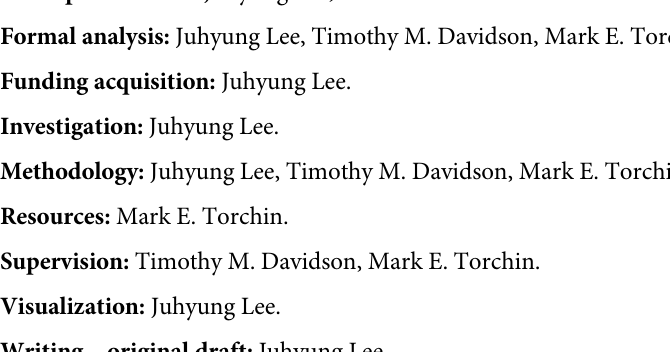
S1 Fig. Experimental cages used in the field experiment. The cages (containing experimental snails) deployed at the rocky intertidal habitats within Smithsonian Tropical Research Insti- tute’s Punta Culebra Nature Center (PCNC), Panama. S1 Table. Flatworm biomass in different snail hosts. Mean blotted wet mass (BWM; mg) of total and individual flatworms collected from different snail species (2012 field surveys). Error values indicate 1 SE and values inside parentheses represent sample sizes (i.e., number of snails dissected). S1 Data. Supplementary data (flatworm infestation data, host choice and behavioral response data, host growth and survival data, and stable isotope